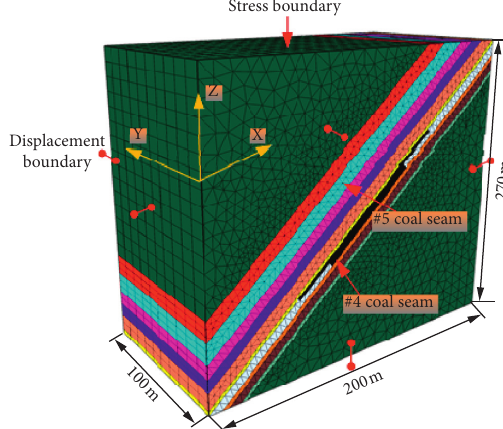
Figure 15: The numerical model of the geological conditions of the 12124 working